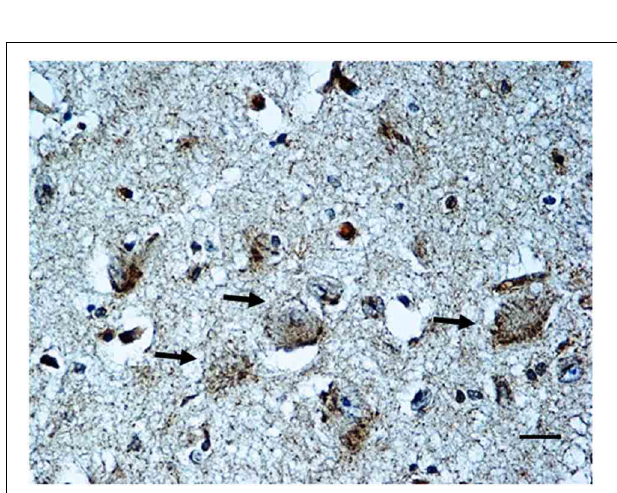
neurons are visible (see arrows). Klüver Barrera staining. Scale bar = 10 µ m. ml, medial lemniscus; scpd, decussation of the superior cerebellar peduncles.